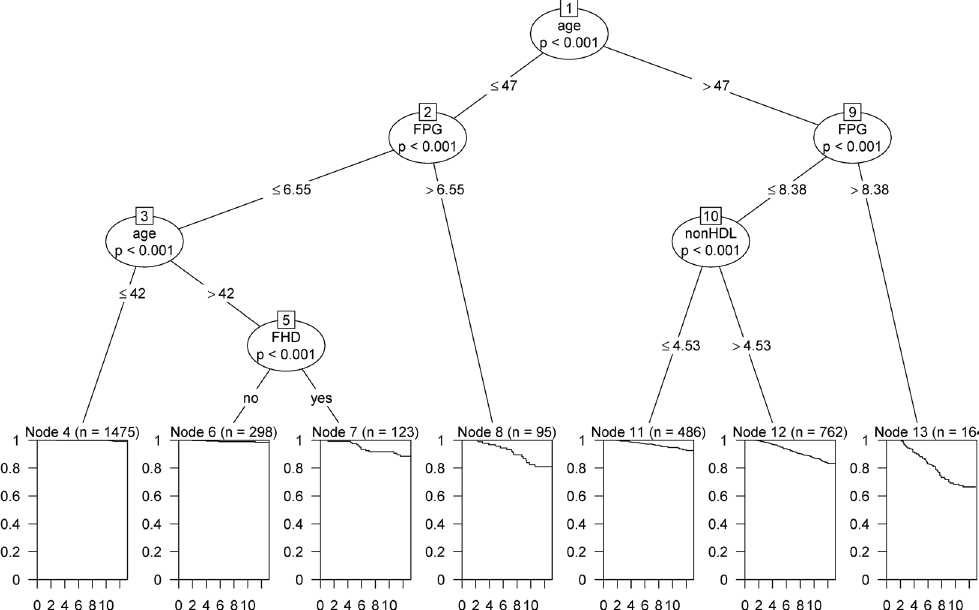
Figure 2. Survival tree model for incidence of CHD events in women and the distribution of survival times in the terminal nodes, Tehran Lipid and Glucose Study (1999–2012). At each level, the most significant split based on log-rank (LR) and permutation P value is shown. FHD : Family history of diabetes; FPG : Fasting plasma